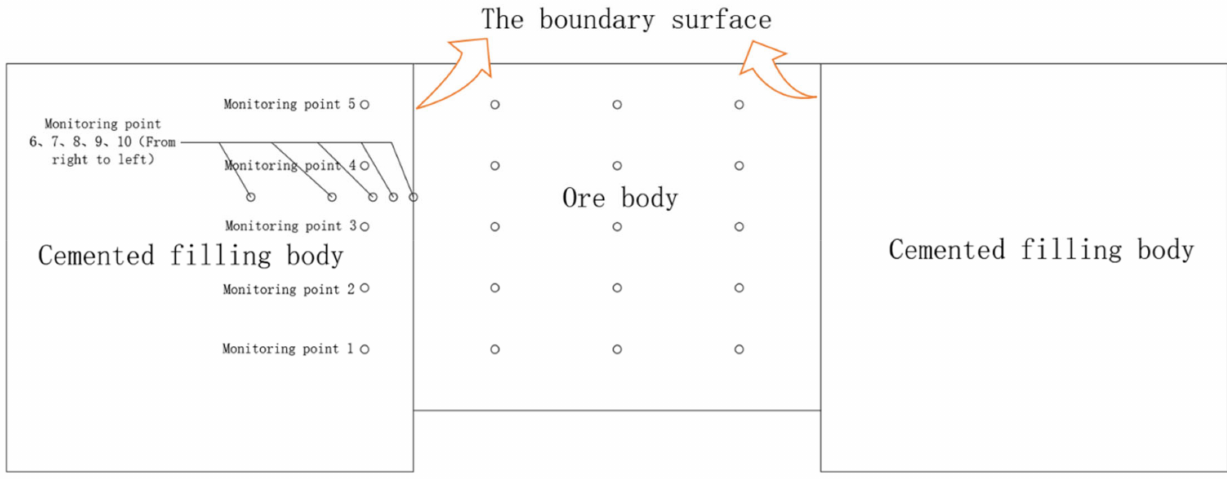
Figure 9. Layout diagram of monitoring